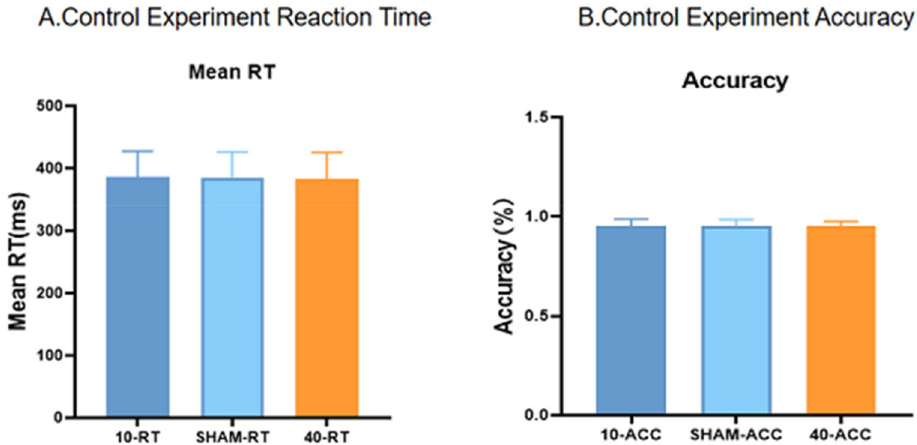
Figure 6. Control experiment results. ( A ) Control experiment reaction time. ( B ) Control experiment